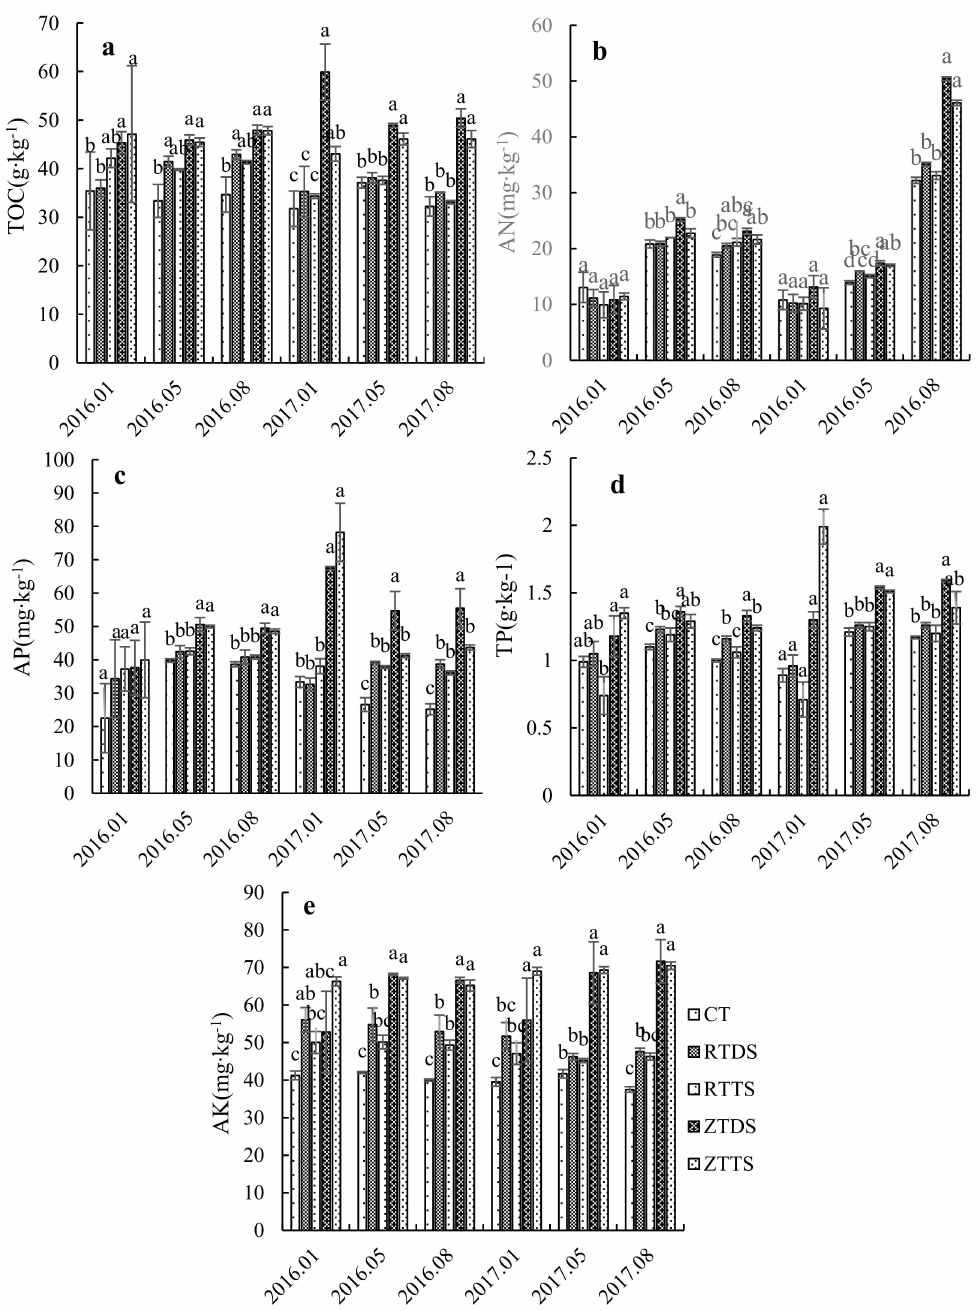
Figure 4. E ff ect of tillage on selected nutrients in the top soil (0–20 cm). Note: ( a ) TOC; ( b ) AN; ( c ) AP; ( d ) TP and ( e )